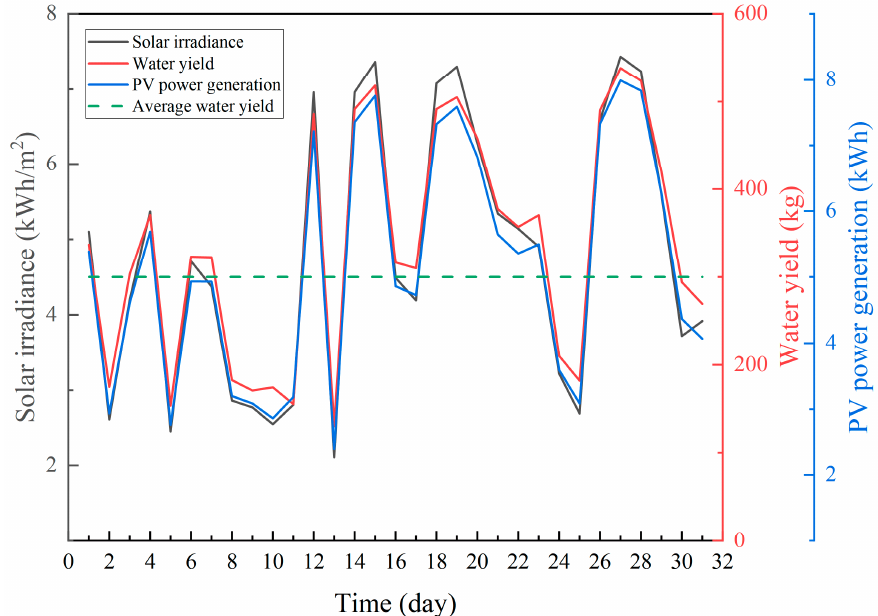
Figure 23. Relationship between daily irradiation, water production, and power generation in July 2021.